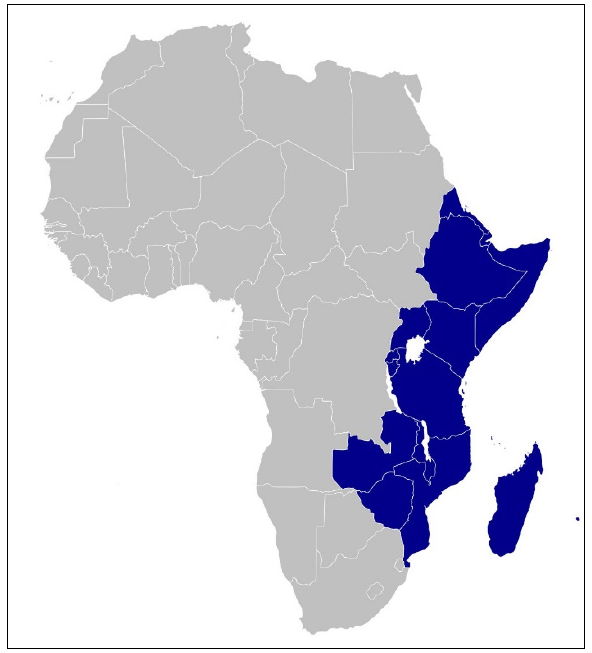
Map of the African continent. The countries shaded in blue comprise the Eastern Africa macro-region as designated by the United Nations (Statistic Division, Department of Economic and Social